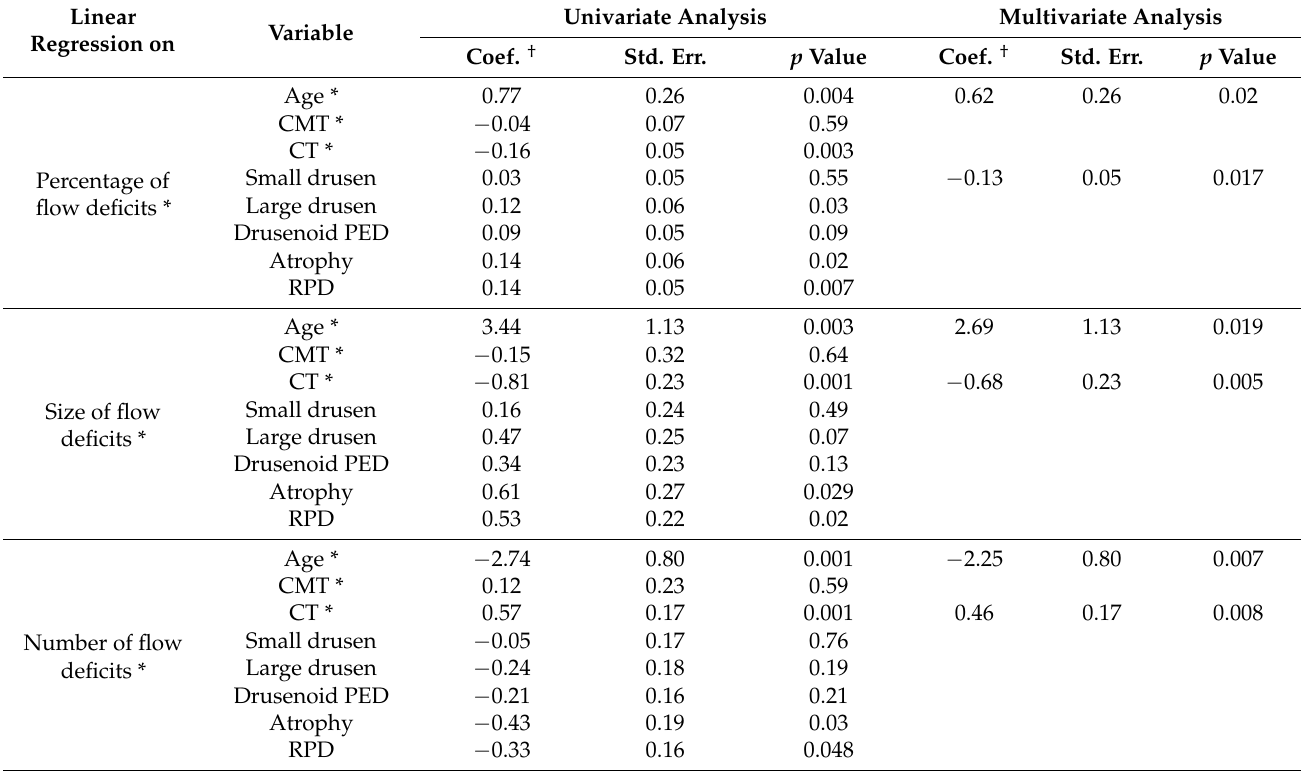
Table 4. Linear regression on percentage of flow deficits (FD), size of FD, number of FD in non-neovascular study eyes. Linear